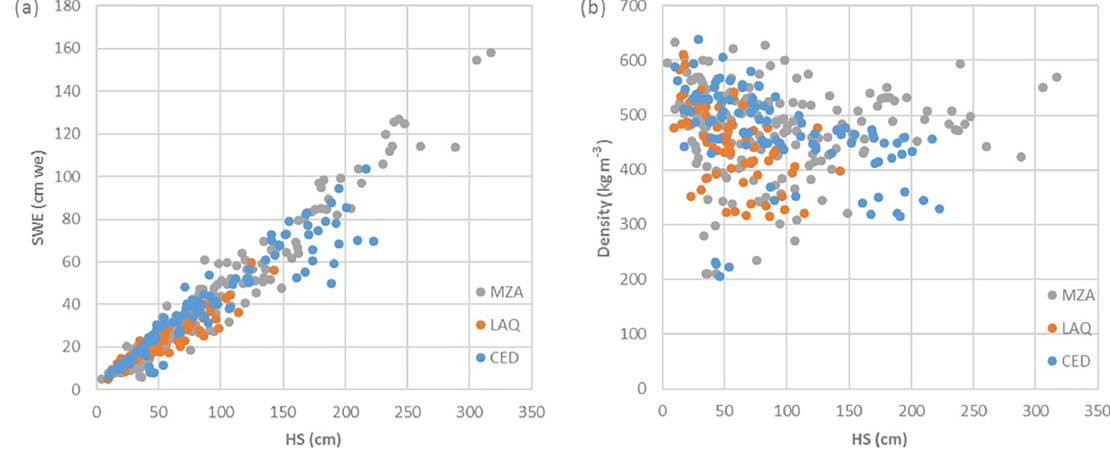
Figure 8. (a) SWE vs. height (HS) and (b) density vs. HS for all snow course data (observed during two snow seasons of 2014–2016 at elevations between 1300 and 2900ma.s.l.) ( n = 649).